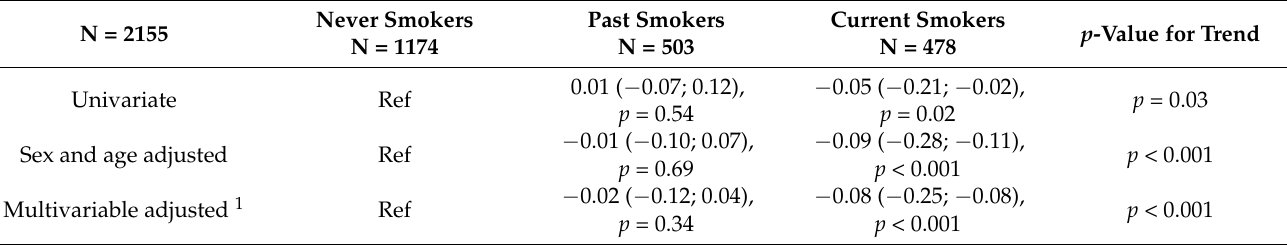
Table 2. Association between smoking status and